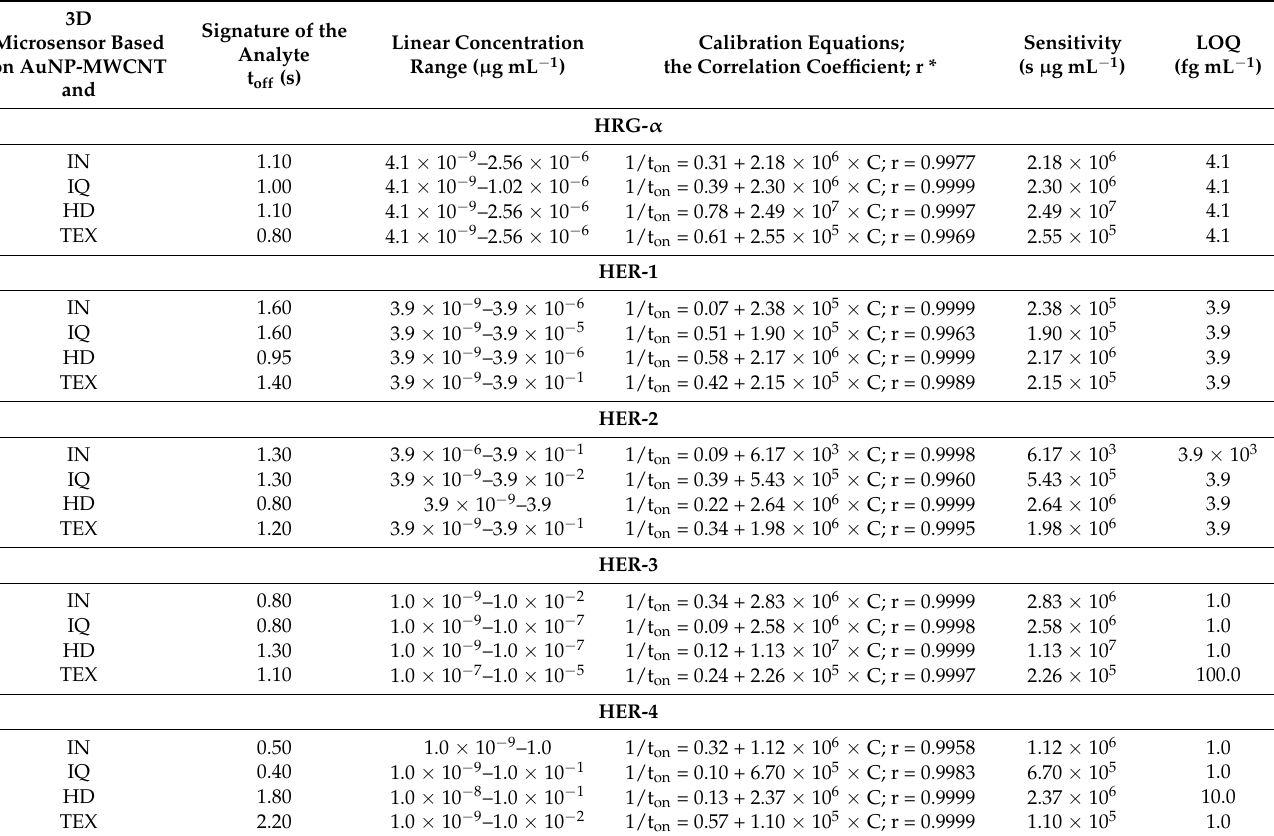
Table 1. Response characteristics of the 3D microsensors used for the assay of HRG- α , HER-1, HER-2, HER-3, and HER-4.